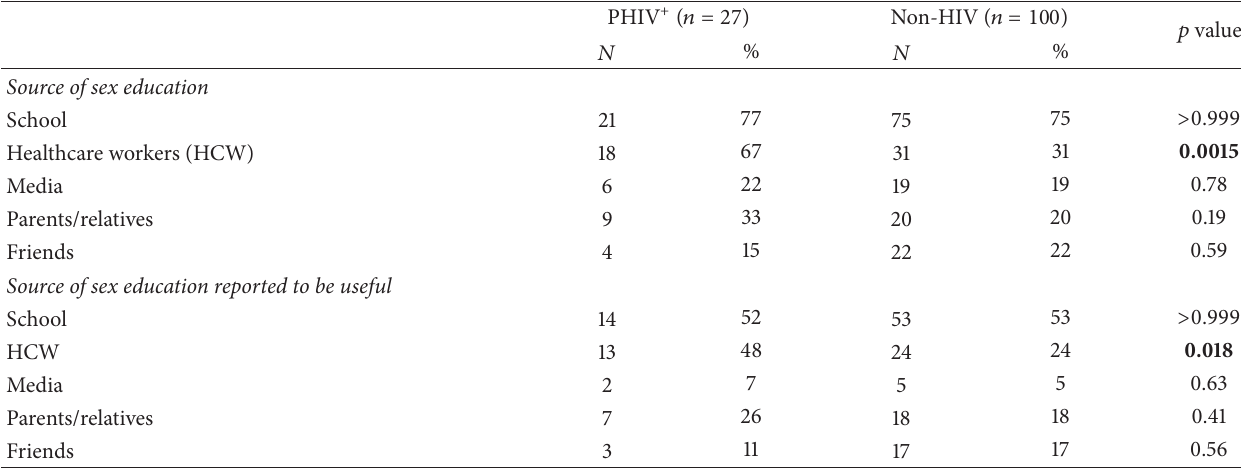
Table 2: Sources of sexual health education for perinatally HIV-infected (PHIV + ) and HIV-uninfected adolescents (non-HIV). PHIV + ( 𝑛 = 27 ) Non-HIV ( 𝑛 = 100